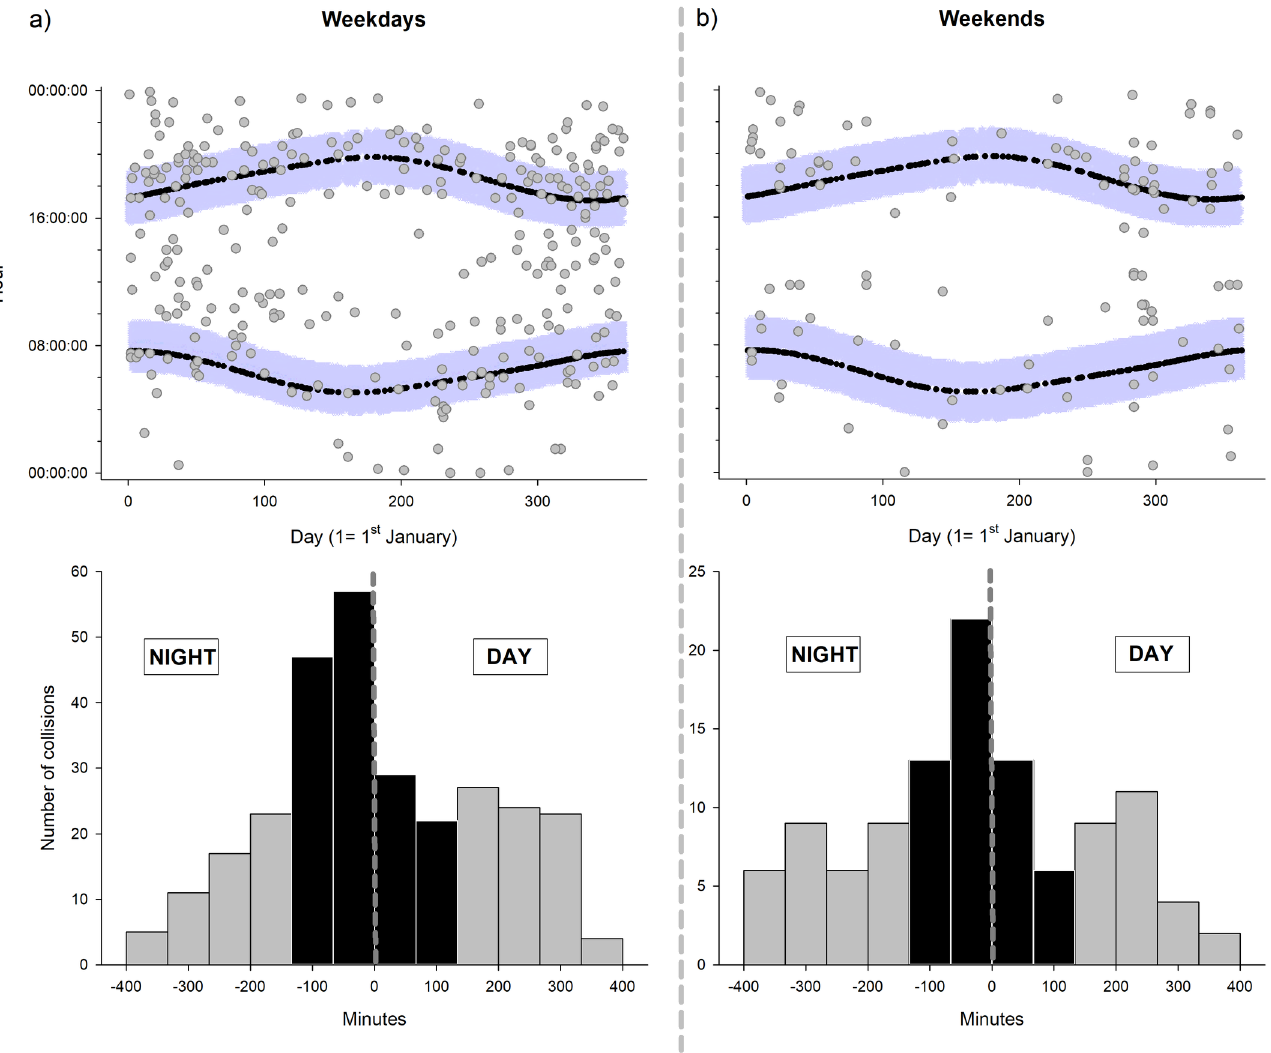
Fig 2. Distribution of dog-vehicle collisions during weekdays (left side) and weekends (right side) . Upper graphs (a, b) indicate daily and annual distribution of dog-vehicle collisions according to solar time of day. Black curved lines indicate time of sunrise and sunset throughout the year, whereas blue areas show the periods around twilight with the highest collision risk as shown in the bottom graph (black bars in c and d). Bottom graphs (c and d) show the distribution of dog-vehicle collisions in relation to the existence of natural light. Negative values on the x-axis indicate minutes in the absence of natural light (minutes until sunrise or after sunset), whereas black bars show periods during and around twilight with high concentration of dog-vehicle collisions.